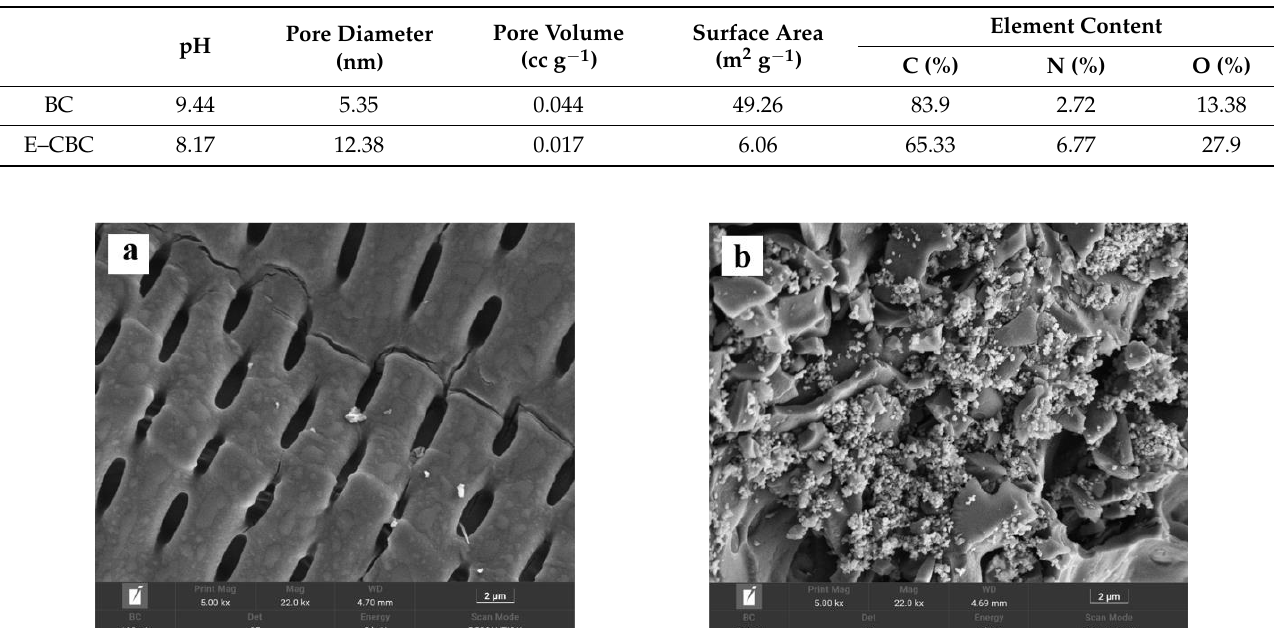
Table 2. Physicochemical properties of BC and E–CBC.